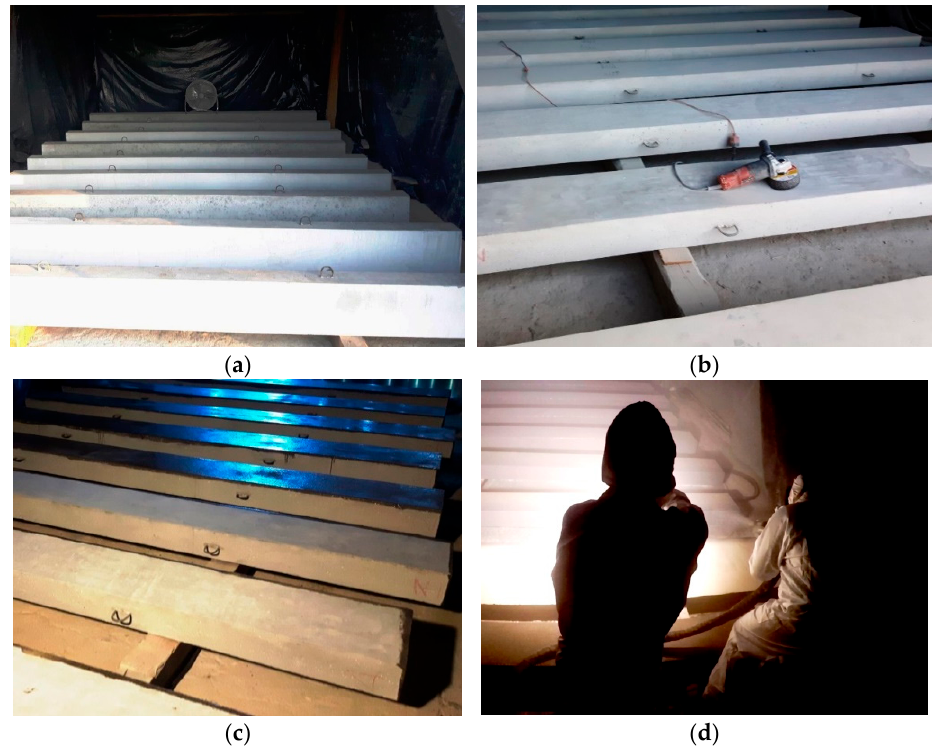
Figure 5. Polyurea application process: ( a ) Positioning the RC beams; ( b ) polishing the beams; ( c ) prime coat application; ( d ) polyurea application.